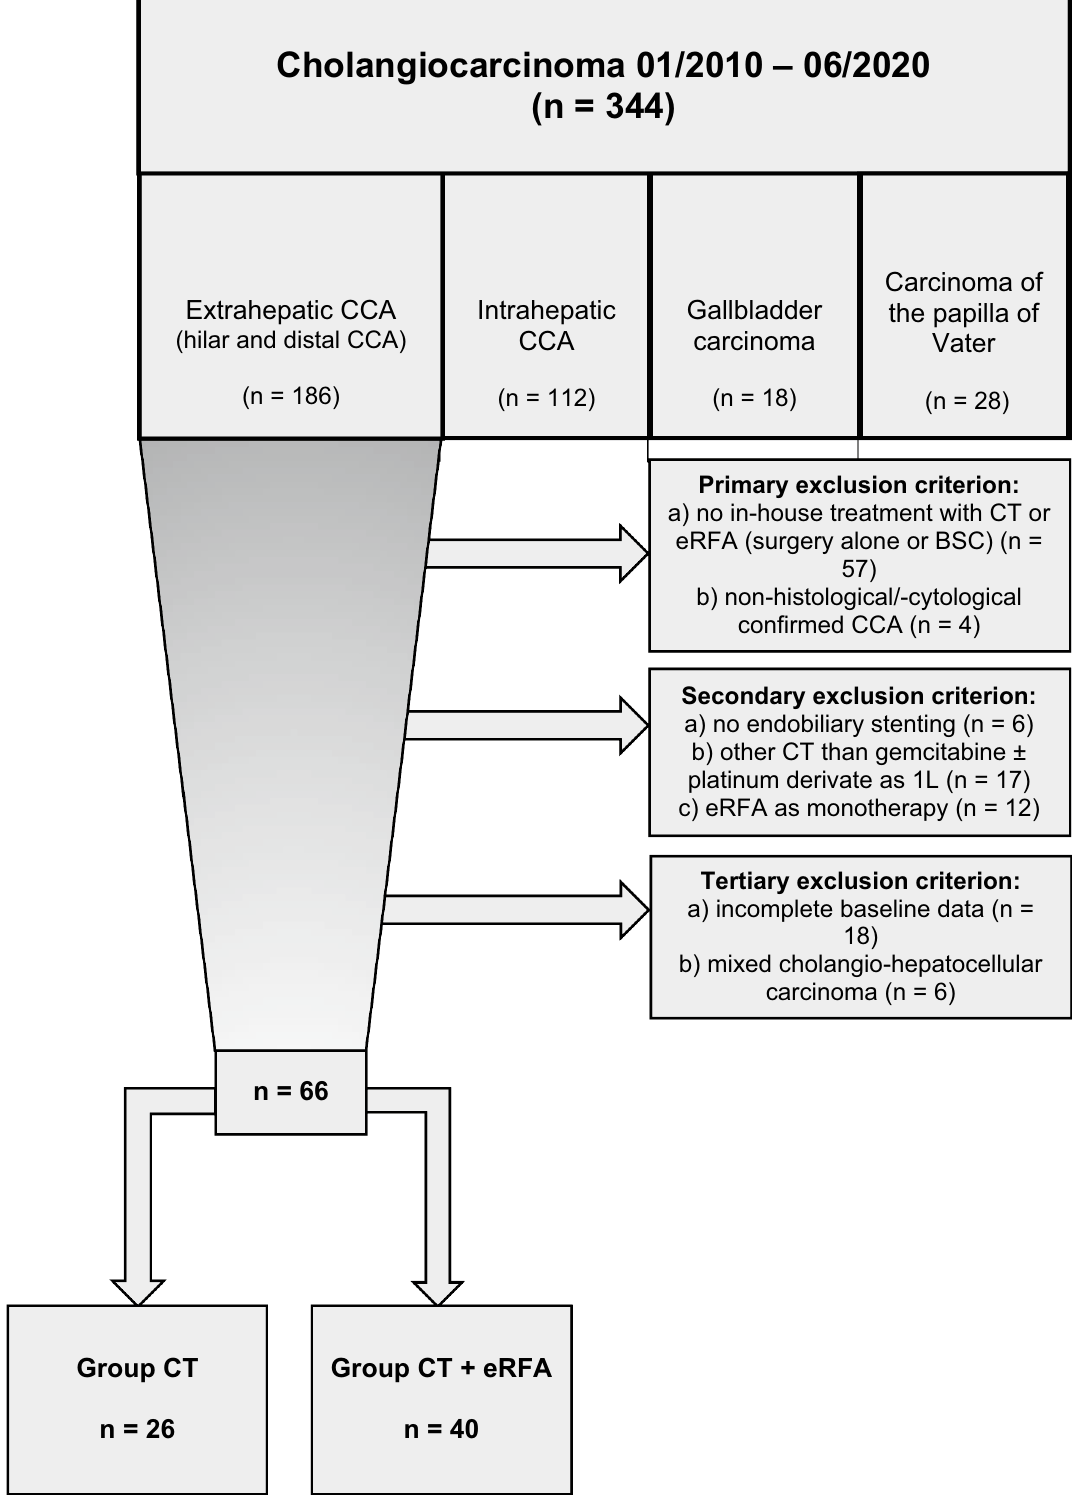
Figure 1. Flow-chart of patients. 1L first-line, BSC best supportive care, CCA cholangiocarcinoma, CT chemotherapy, eRFA endobiliary radiofrequency ablation, n